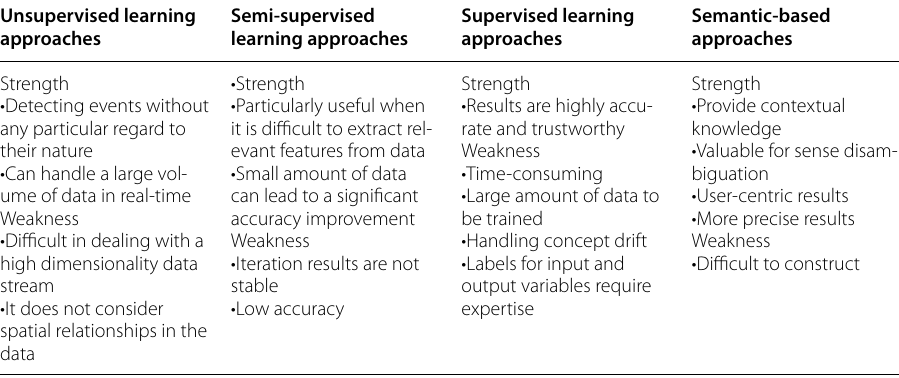
Table 5 Summary of strength and weaknesses of event detection techniques and their attributes Unsupervised learning